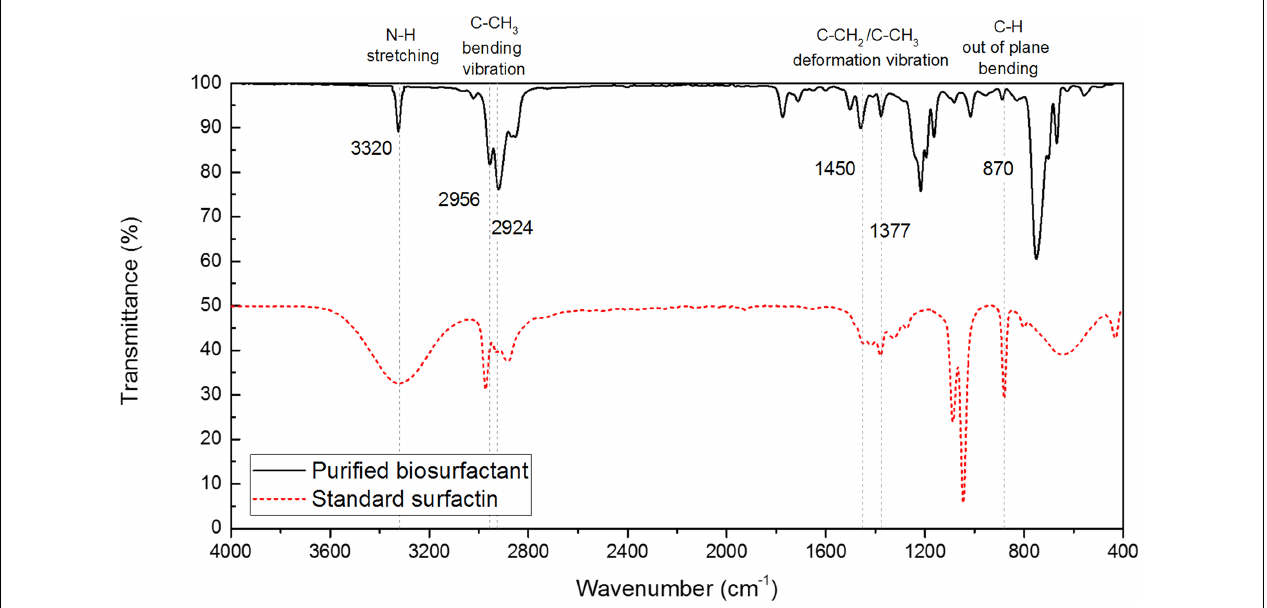
FIGURE 2 | FT-IR spectra of extracted biosurfactant produced from B. subtilis and standard surfactin.